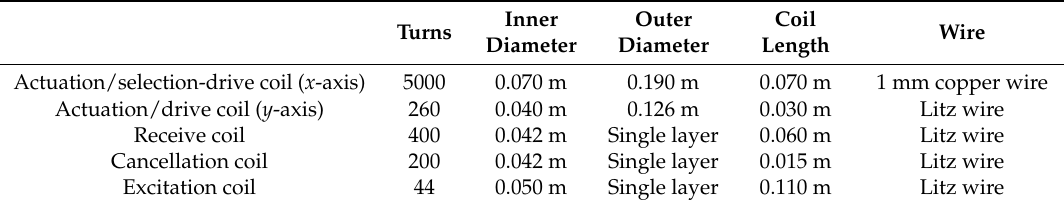
Table 1. Geometrical specifications of the coils in the 2D MPI